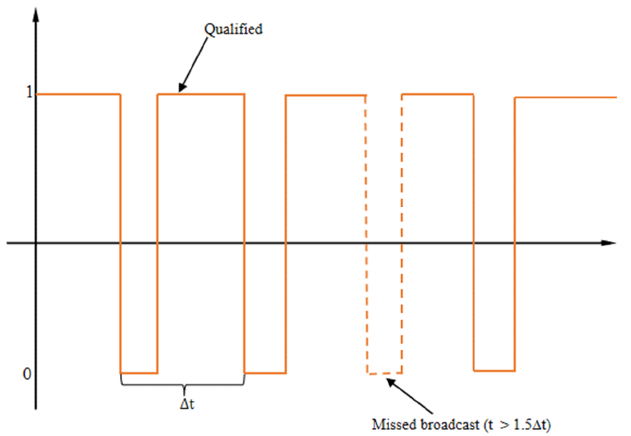
Figure 5. Pulse sequence diagram.